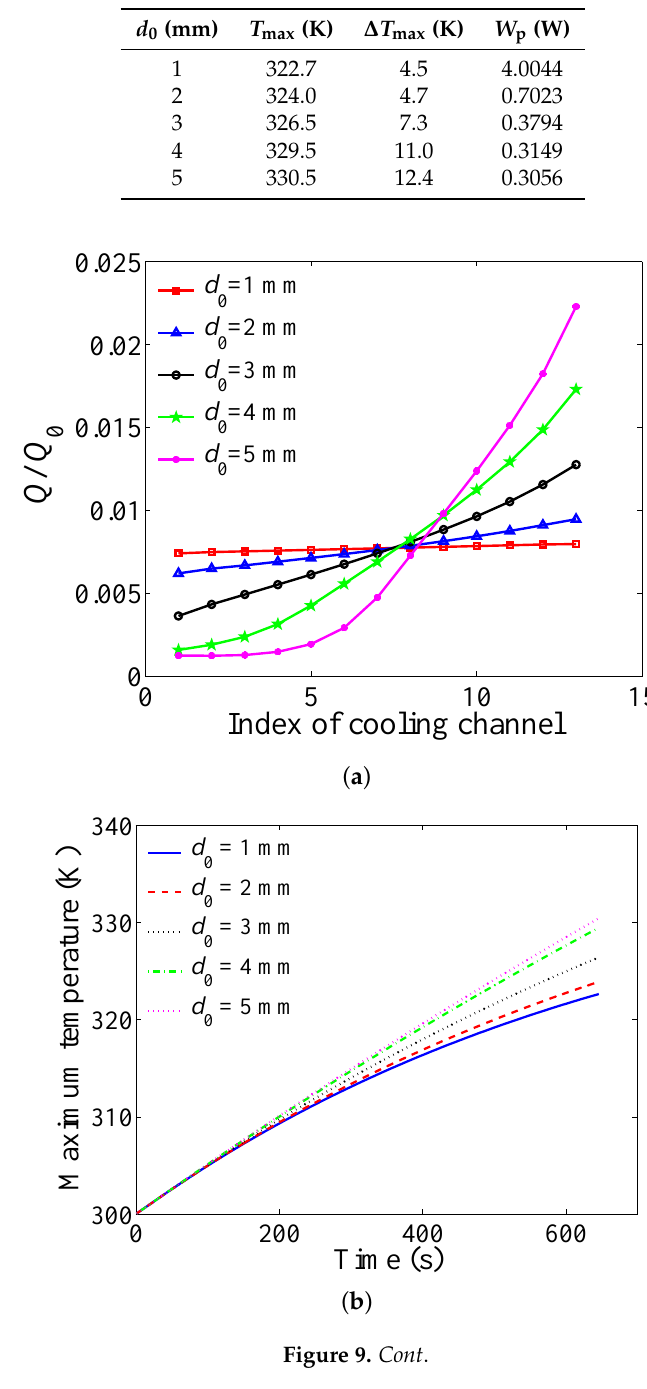
Table 7. Numerical results for various cell spacings.